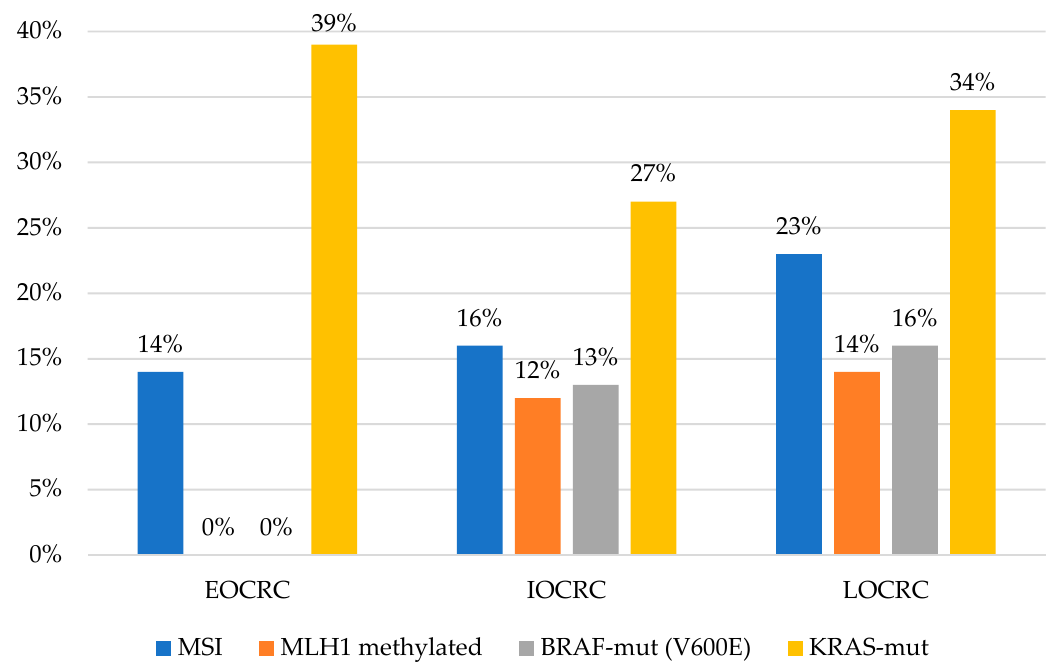
Figure 2. Distribution of molecular features of tumors according to the age of onset. Table 3. Molecular features of tumors and germline genetic analysis of patients according to the age of onset. The OS and CSS curves were performed. According to the age of onset, significant differences in OS and CSS were seen for each group, with p = 0.000003 and p = 0.01, respectively. (Figure 3).